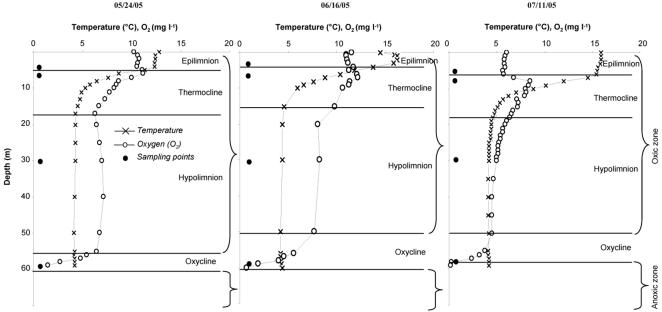
Vertical profiles of temperature and oxygen concentration measured at the three sampling dates in Lake Pavin.